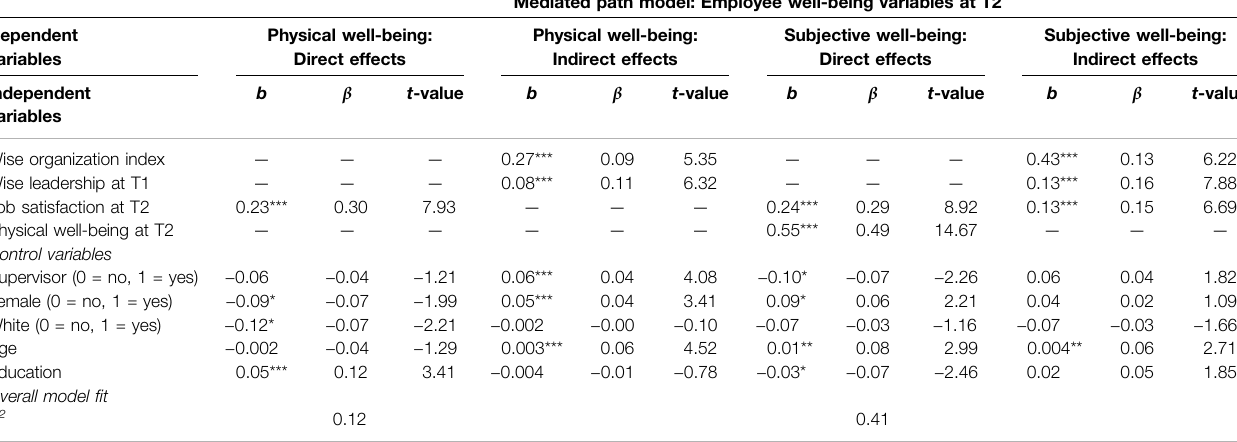
Mediated path model: Employee well-being variables at T2